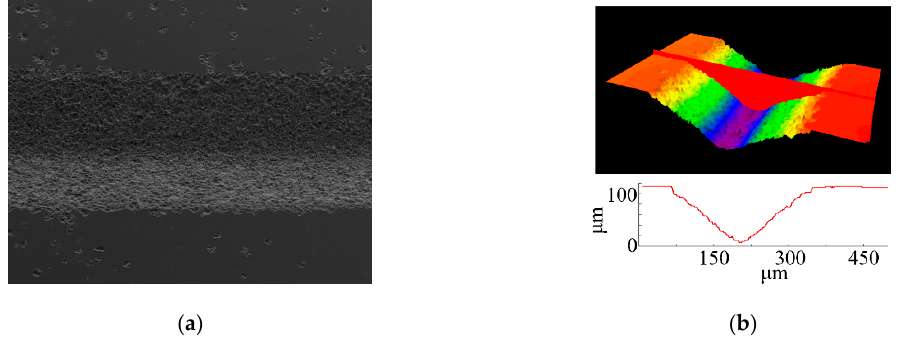
Figure 11. Linear groove pattern. ( a ) Sample of the microgroove and ( b ) profile of the microgroove.